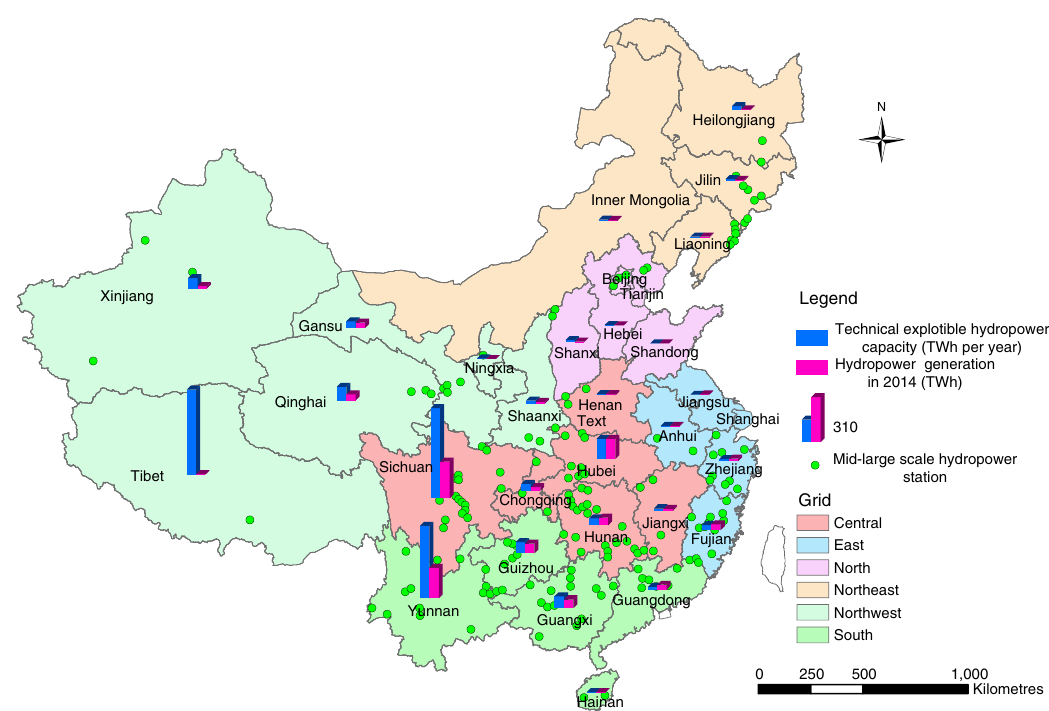
Figure 2 | Spatial distribution of hydropower resources and production in China. The map shows the technically exploitable hydropower resources, hydropower generation (2014) and major hydropower stations in all provinces and municipalities of mainland China. The boundaries of the six inter- provincial regional power grids are also shown. Most of the hydropower bases are located in the central and southern provinces, including Sichuan and Yunnan, while the northeastern and northern provinces have very low hydropower generation.